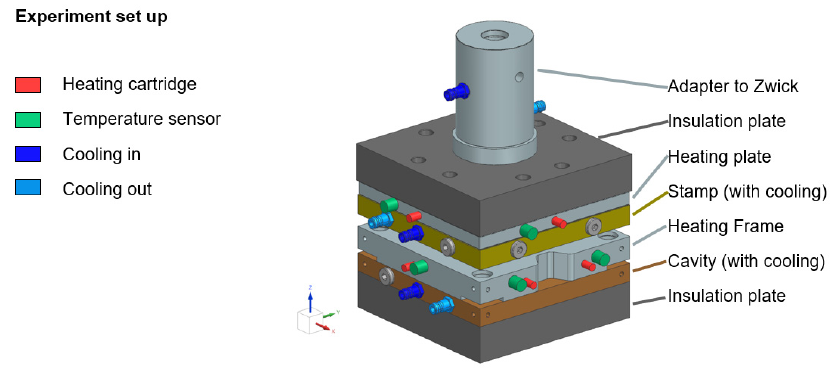
Figure 5. Consolidation experiment setup.